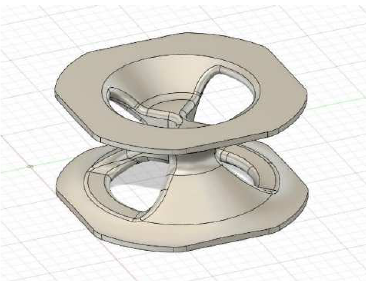
Figure 4. Acoustic foam inspired unit cell (8 × 8 × 4 mm 3 ).